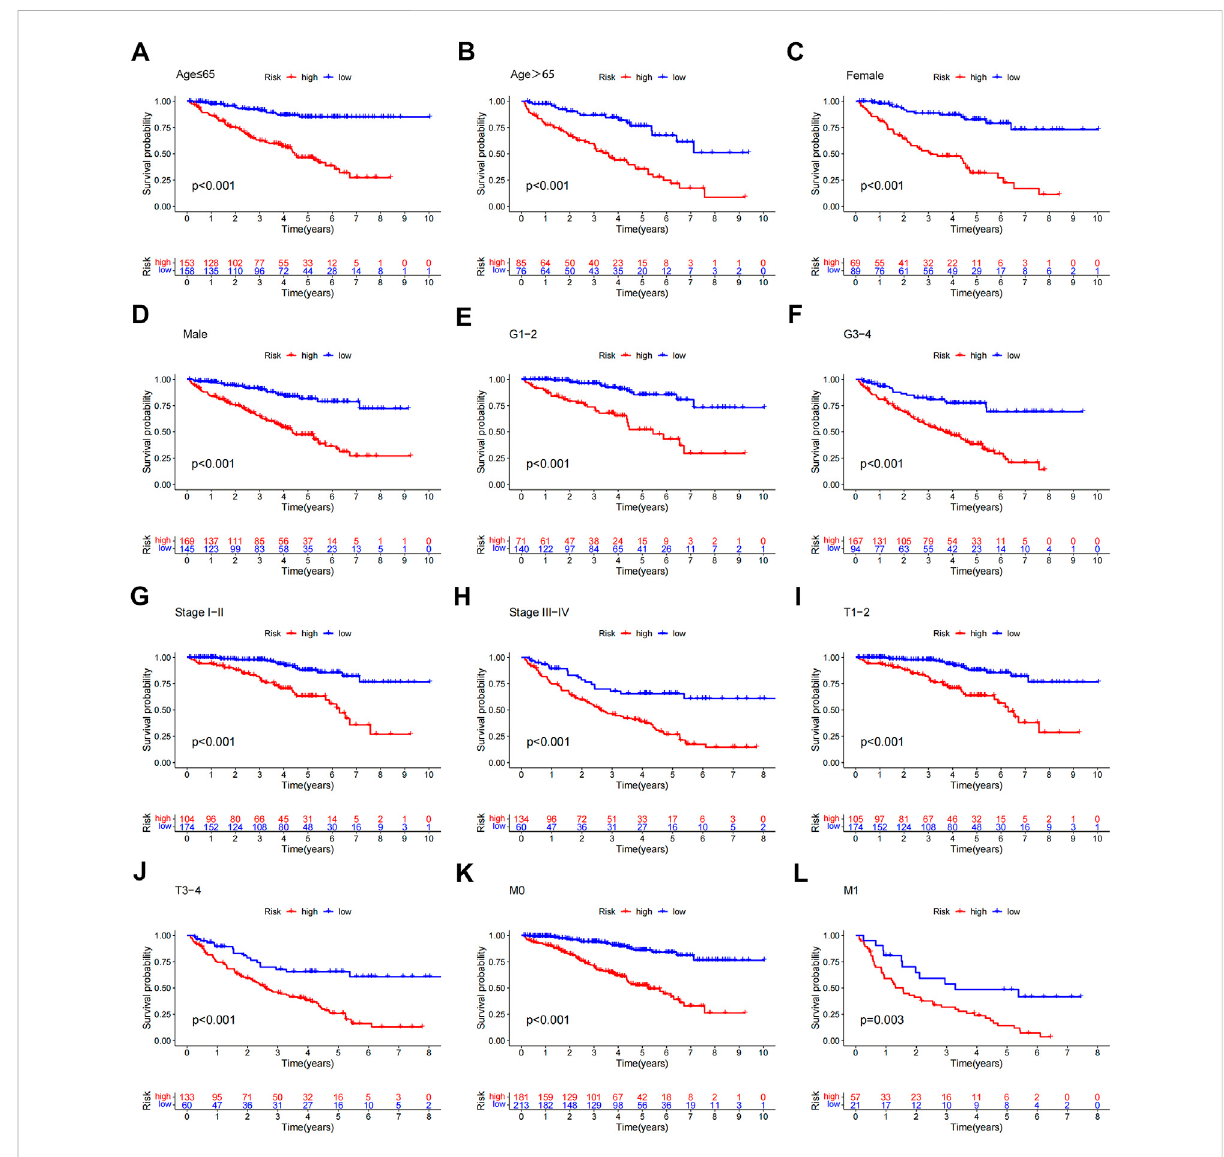
FIGURE 7 Kaplan-Meier survival curves for patients divided into high- and low-risk groups according to the ranking of different clinicopathological variables. (A – B) Age. (C – D) Gender. (E – F) Grade. (G – H) Stage. (I – J) T Stage. (K – L) M Stage. T, tumor; M, distant